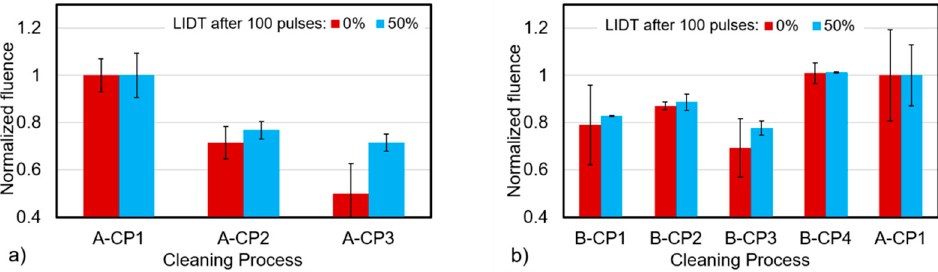
Figure 6. The 0% and 50% LIDT for ( a ) cleaning process set A and ( b ) cleaning process set B. The estimated fluences are normalized to the values of the standard cleaning A-CP1.